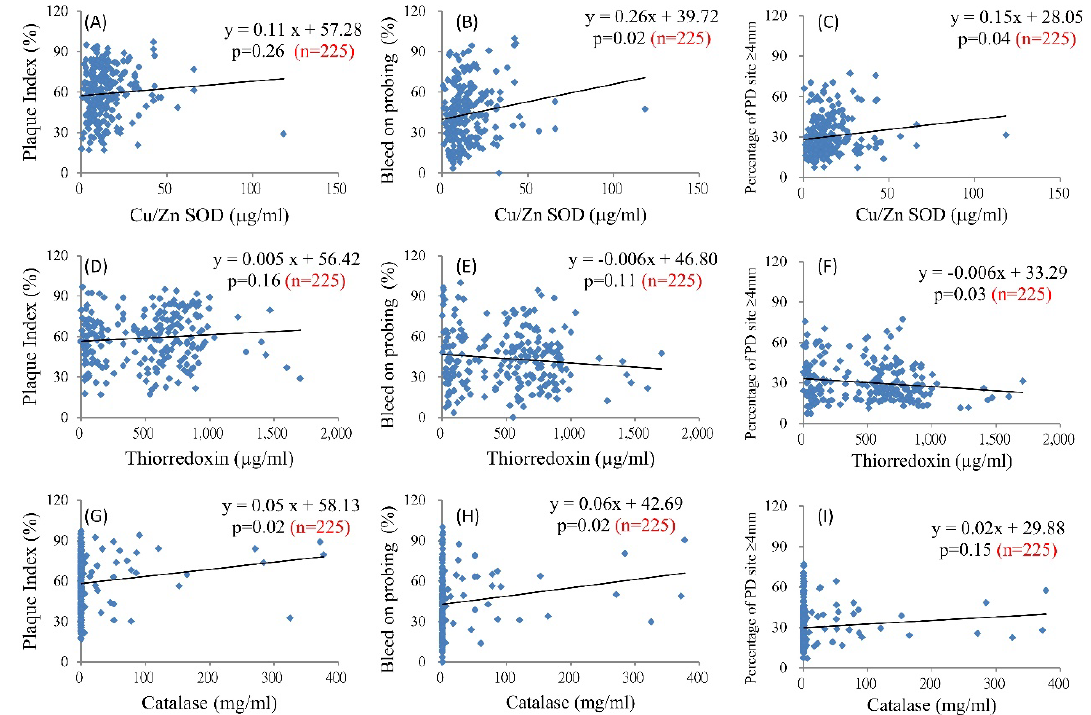
Figure 2. Association between the salivary antioxidants and clinical periodontal parameters. Salivary Cu/Zn superoxide dismutase (SOD) and dental clinical parameters ( A – C ); salivary thioredoxin 1 and dental clinical parameters ( D – F ); and salivary catalase and dental clinical parameters ( G – I ).